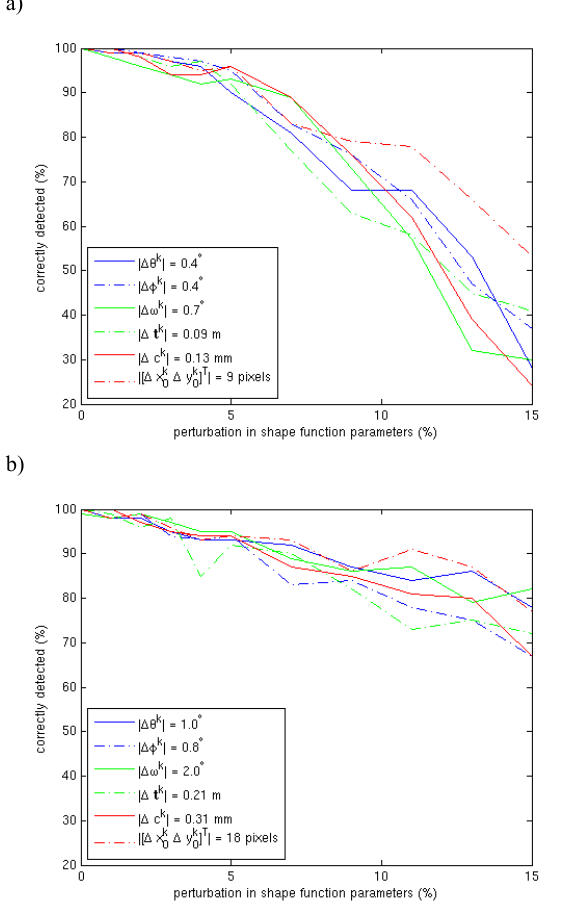
Table 2. Percentages of trials where all images of changed orientations were correctly detected and RMSE of estimated deformation at the target points in successfully converged correct detections for a noise level of = 0.1 pixel and for a moderate change in the orientations: focal length 0.2 mm, principal point 10 pixels, rotation angles 2 degrees each, and pose of projection center 0.1 m.